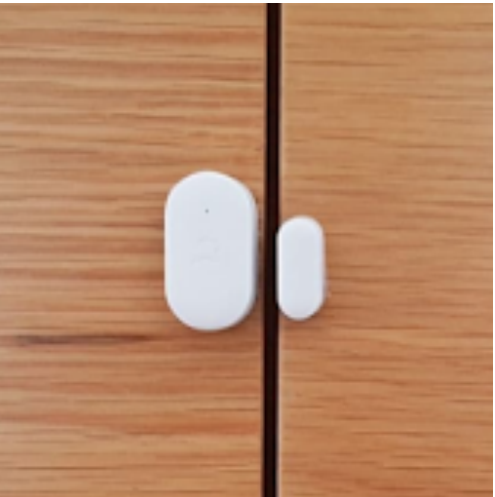
Figure 19. Door and window sensor to detect opening and closing events and the current state.